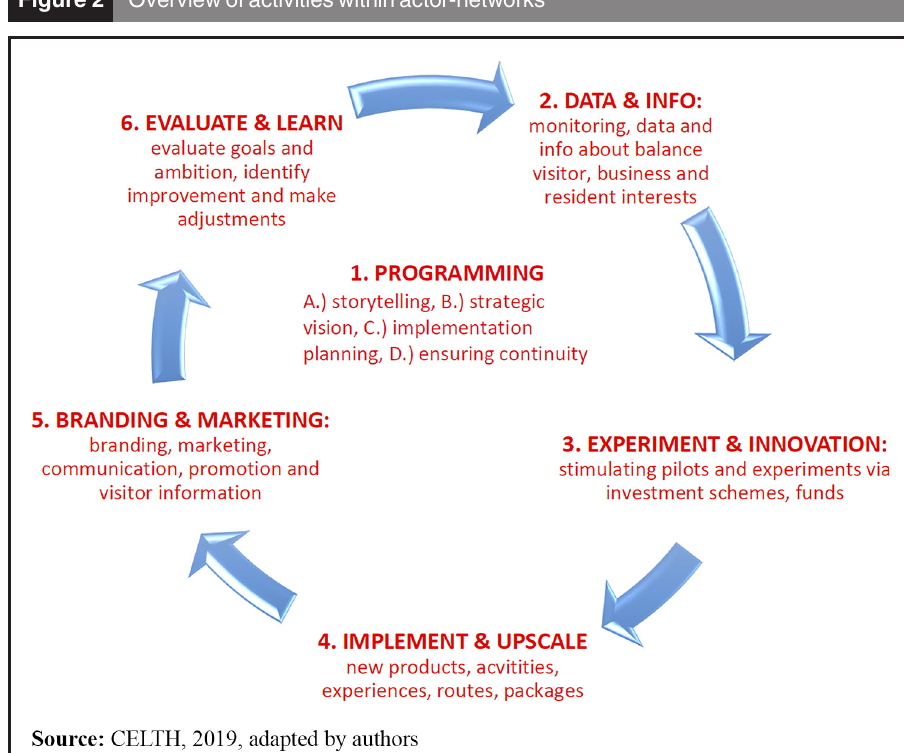
Figure 2 Overview of activities within